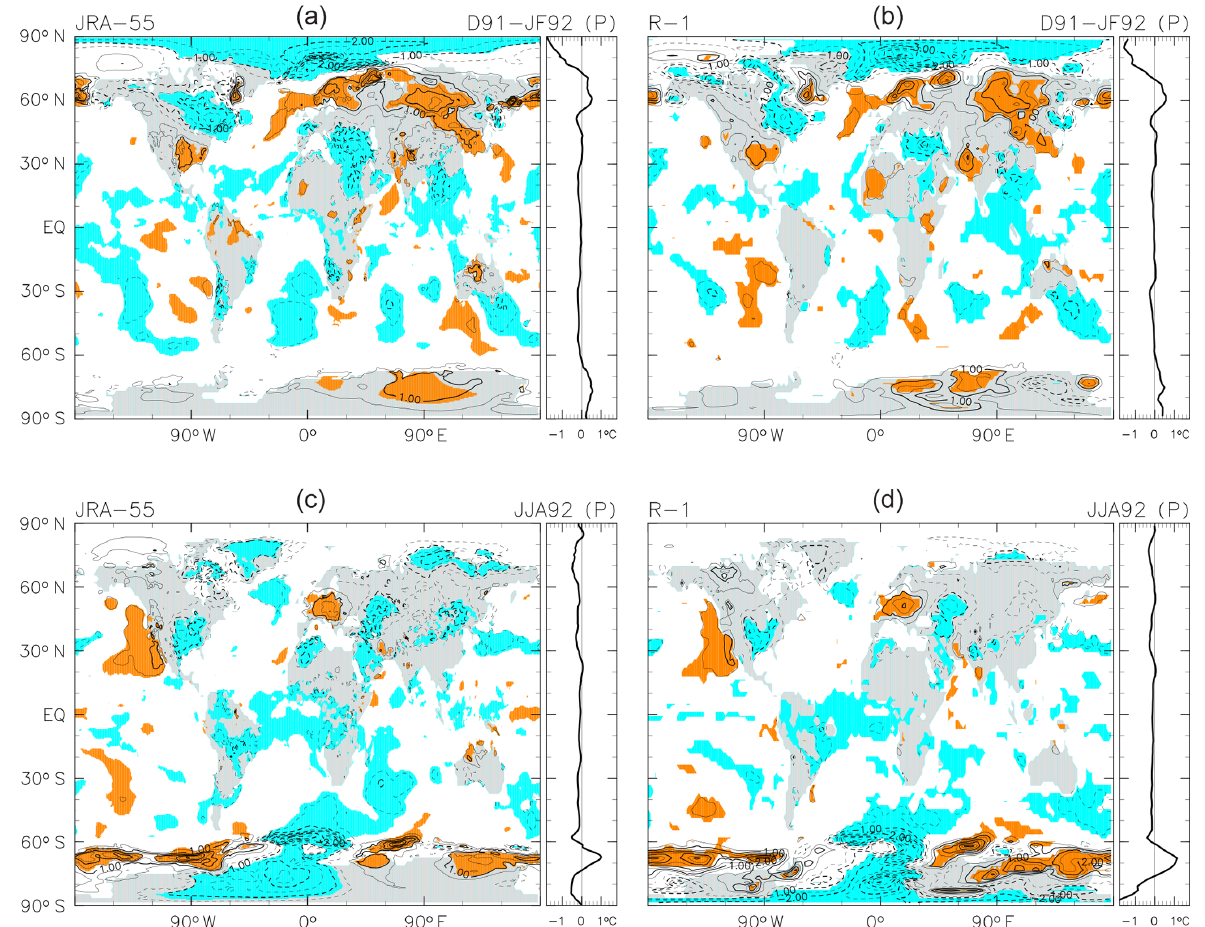
Figure 3. As for Fig. 2, but for the anomalies averaged from December 1991 to February 1992 (a, b) and from June to August 1992 (c, d) following the Mount Pinatubo eruption as calculated using JRA-55 (a, c) and R-1 (b, d) . The contour interval is 0.5K, without 0.0K lines. Coloured shading denotes anomalies that are positive (orange) or negative (blue) with magnitudes exceeding 1 SD of the 3-month mean R(t) at that